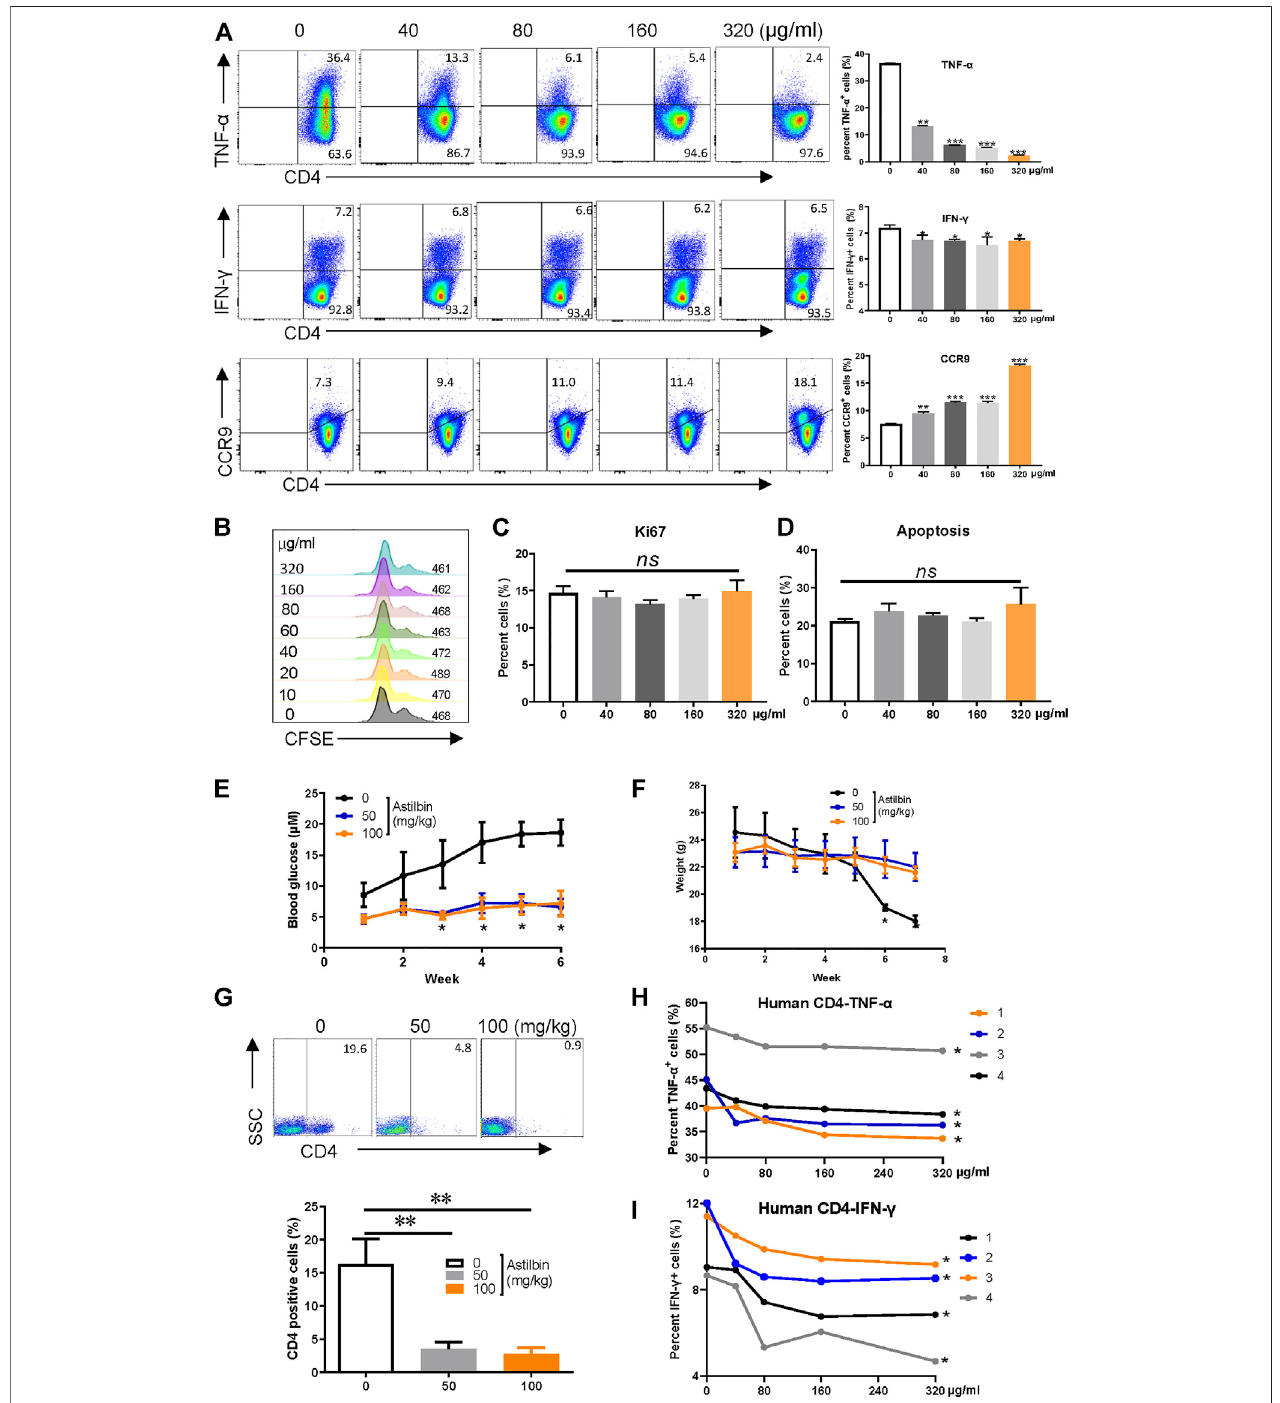
FIGURE 1 | Astilbin decreases CD4 + T cell functions. (A) TNF- α + , IFN- γ + , and CCR9 + of CD4 + T cells treated with various doses of astilbin. Mean ± SD; n = 3. (B) CD4 + TcelldivisionbyCFSEdilution. (C) ProliferativecapacityofCD4 + TcellsevaluatedbyKi67.Mean±SD; n =3. (D) Apoptosisofastilbin-treatedCD4 + Tcellsstained byAnnexinVandPI.Mean±SD; n =3. (E) BloodglucoselevelsofNODmiceintraperitoneallyinjectedwithastilbin.Mean±SEM; n =10. (F) WeightcurvesofNODmice. Mean ± SEM; n = 10. (G) In fi ltrated CD4 + cells in the pancreas of NOD mice. Mean ± SD; n = 10. Variations of TNF- α (H) and IFN- γ (I) in human CD4 + T cells as treated by astilbin for 24 h. Mean ± SEM; n = 4. All ex vivo experiments were repeated at least three times. Experiments of astilbin-treated NOD mice were conducted twice. p values (* p ≤ 0.05; ** p ≤ 0.01; *** p ≤ 0.001; ns, no signi fi cant difference) determined by one-way ANOVA (A – C,G) , two-way ANOVA (E,F,H,I) .